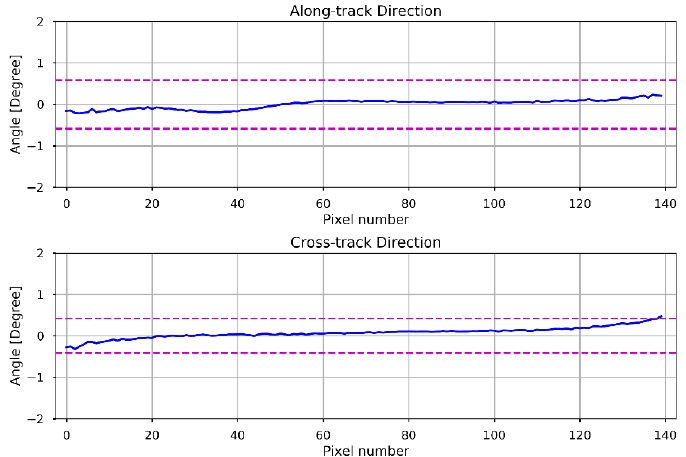
Figure 17. Same as Figure 11 but for the medium resolution OMPS-NM data on